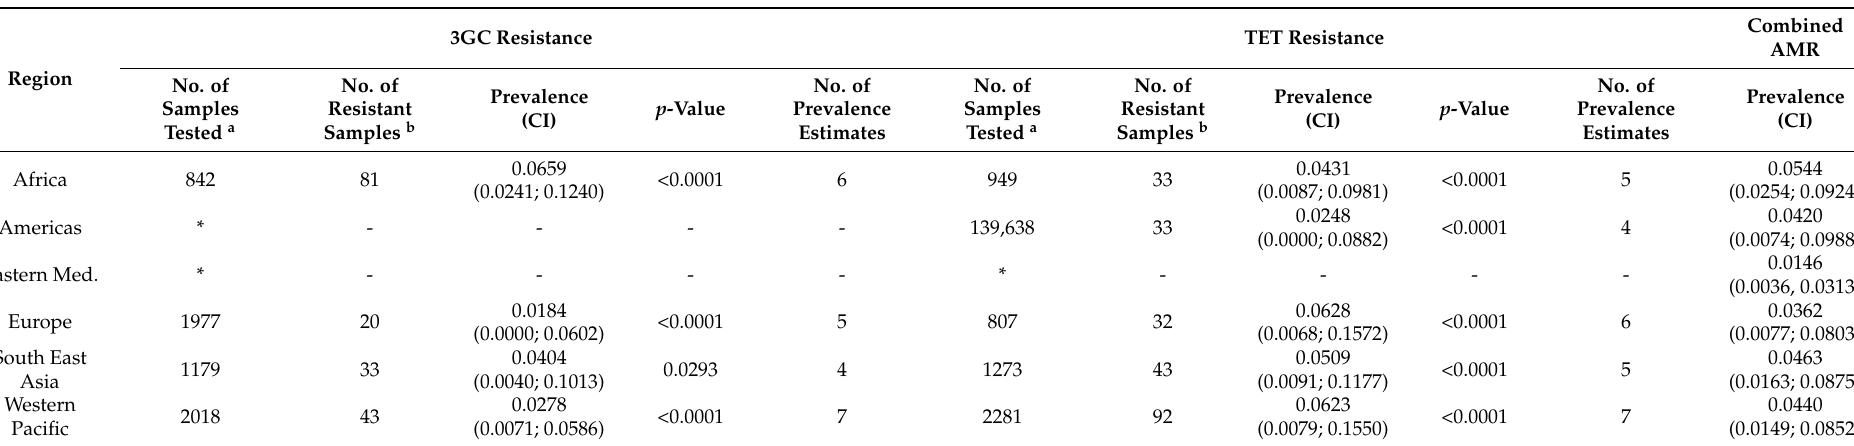
Table 3. Pooled prevalence estimates of antimicrobial resistance in food crops sub-grouped by antimicrobial class and world region.